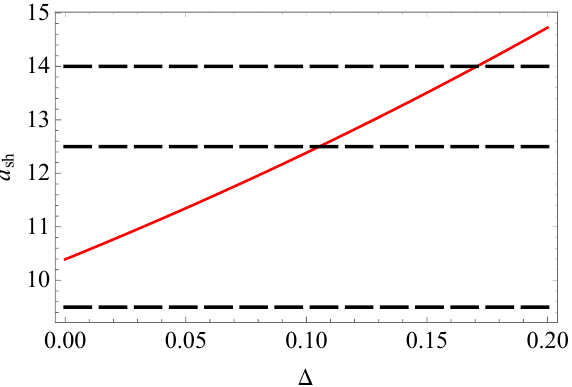
Figure 2. The theoretically predicted diameter per unit mass d sh , for black holes with Barrow entropy, as a function of ∆ and for fixed M = 1. The horizontal dashed lines at 9.5 and 12.5 mark the 1 σ bounds according to d M 87 ∗ observations, given in (36), while the horizontal dashed line at 14 marks the upper 2 σ bound (the lower 2 σ bound is not shown since it corresponds to the not physically interested region ∆ < 0).